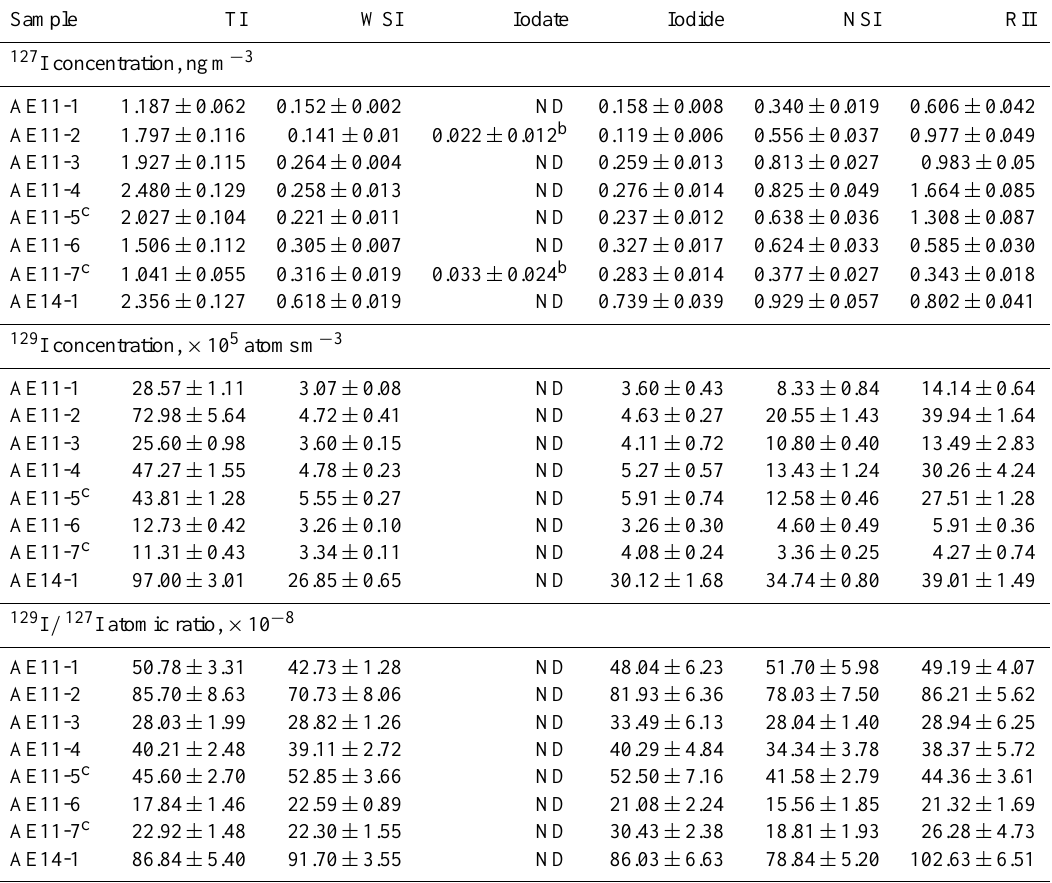
Table 2. Analytical results of chemical species of 127 I and 129 I in aerosols collected from Risø, Denmark during spring 2011 and winter 2014 a